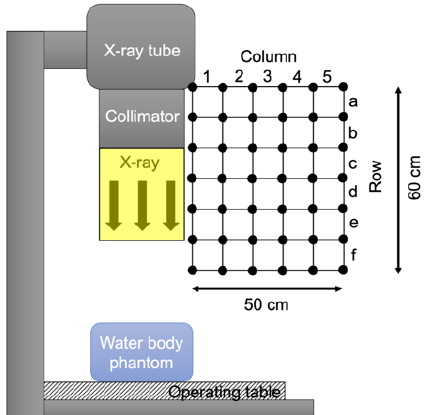
Figure 2. Setting for scattered radiation distribution measurements near the physician’s lens of the eye. The black circles show the placement of radio-photoluminescence glass dosimeters (RPLD). Areas (row, column) are set with a grid with 10 cm spacing.